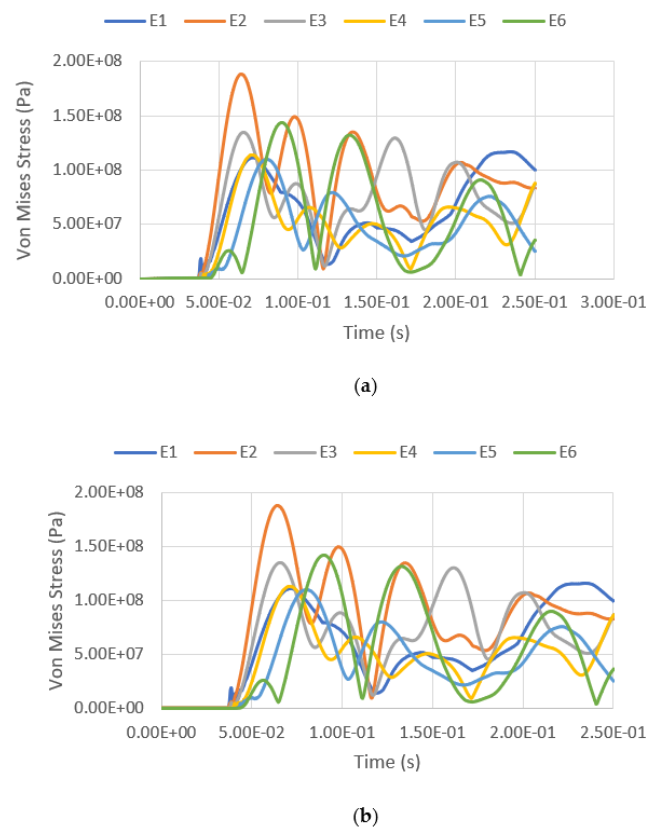
Figure 22. Equivalent stress versus time under blast intensity of 380 kg TNT equivalent mass 25 m away, ( a ) 100% fill and ( b ) 0% fill. Table 7. Table summary of maximum equivalent stress of the storage tank under blast loadings. Table 6. Z-coordinates of the elements.